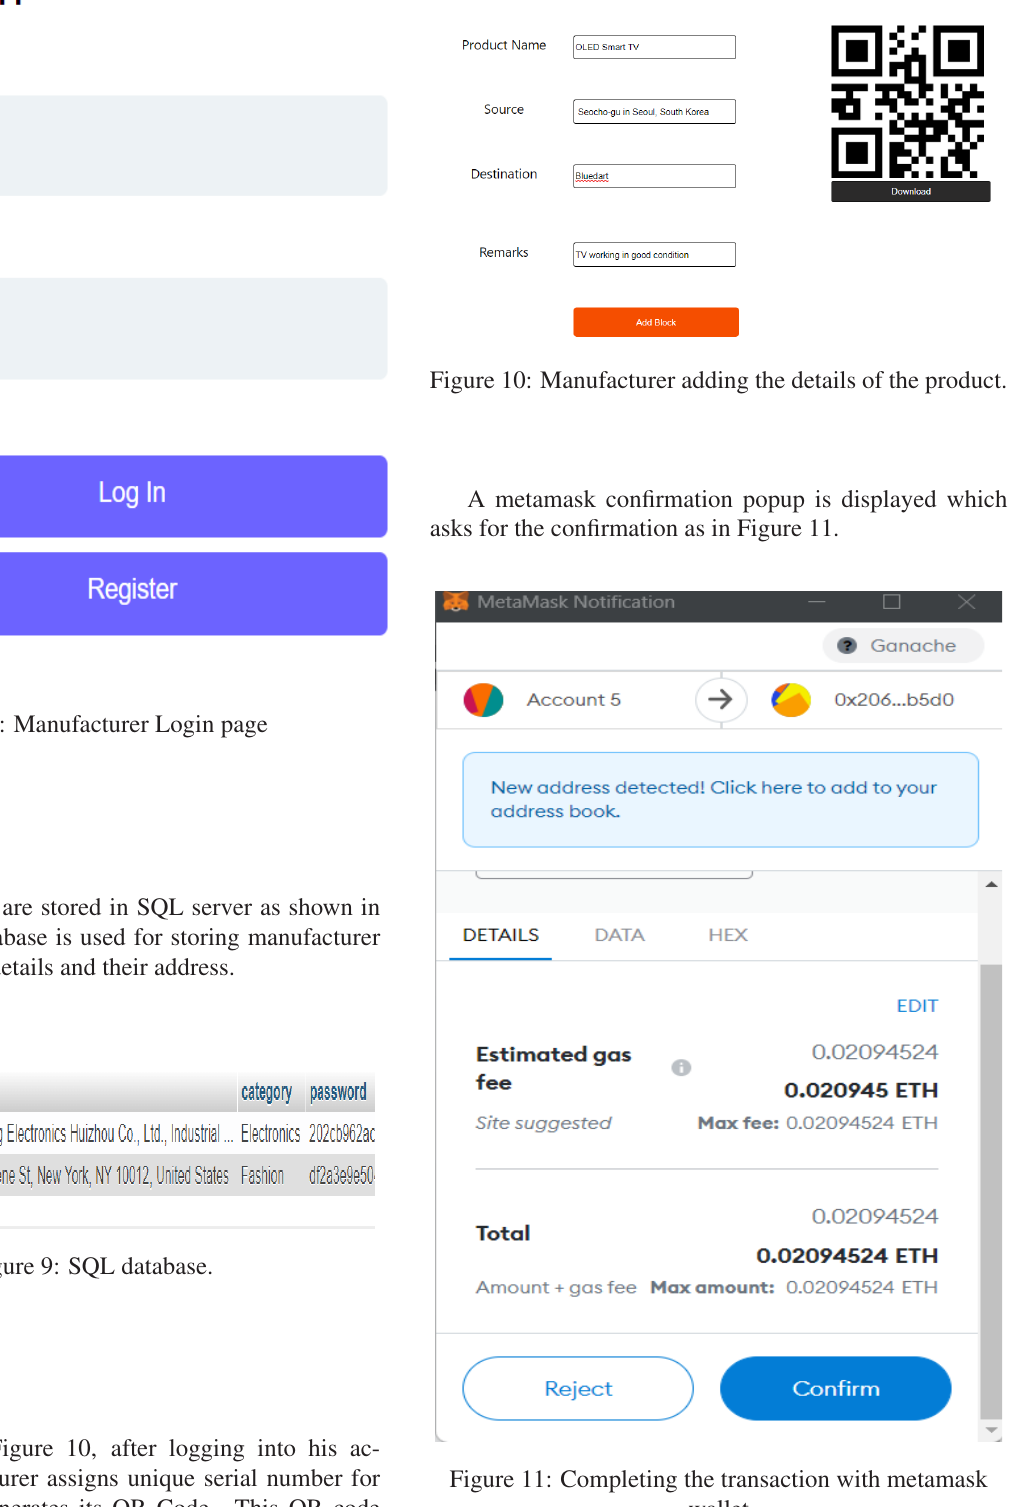
Once confirmed the block containing all details are added to blockchain and success page is displayed as shown in Figure